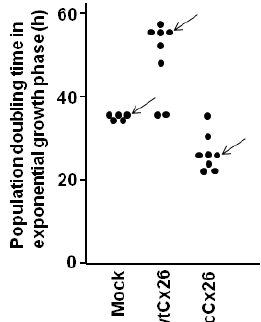
Figure A2. Expression of Cx43 protein in FaDu cells. Immunoblotting was performed with two different anti-Cx43 antibodies, mAb (Invitrogen; clone CX-1B1) and pAb (Sigma-Aldrich). As a positive control, IAR20 cells were used. For indirect immunofluorescence, the fluorescent signals of Cx26 protein were visualised by Alexa-488. Nuclei were stained with DAPI. Note that no positive signals for Cx26 protein are detected. Scale bar, 20 µm.